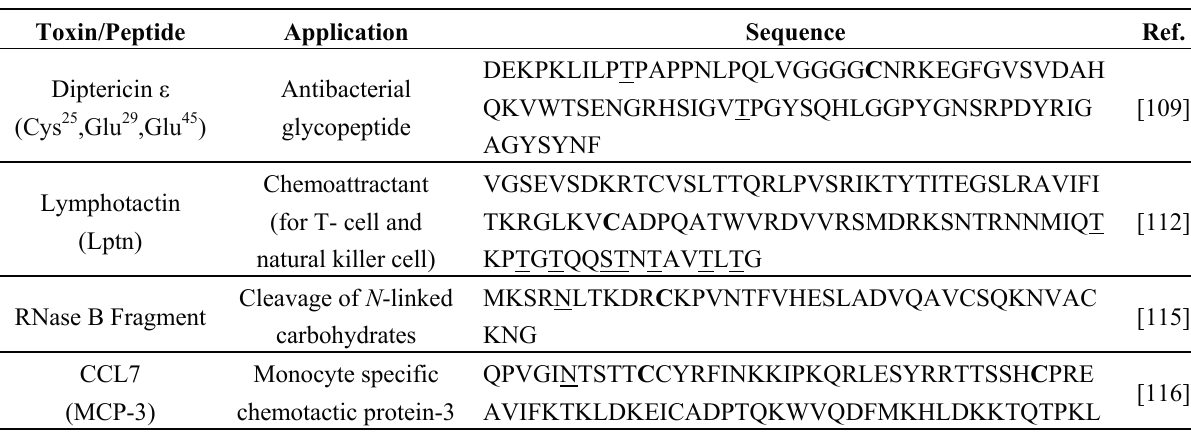
Table 4. Examples of the applications of NCL to synthesize glycopeptides and glycoproteins. Cysteine residues used as ligation sites are in bold and larger font. Glycosylation sites are shown with underlining